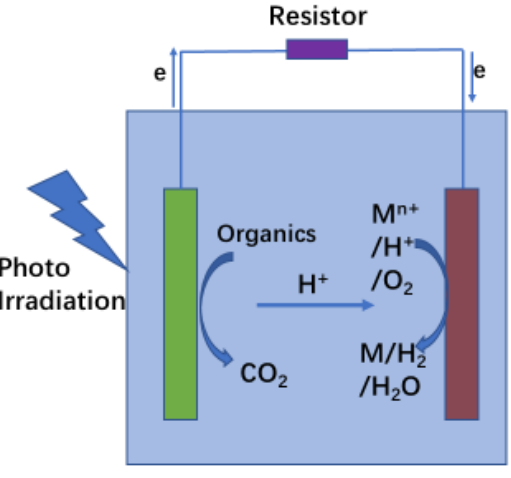
Figure 4. Principle for a photo fuel cell.